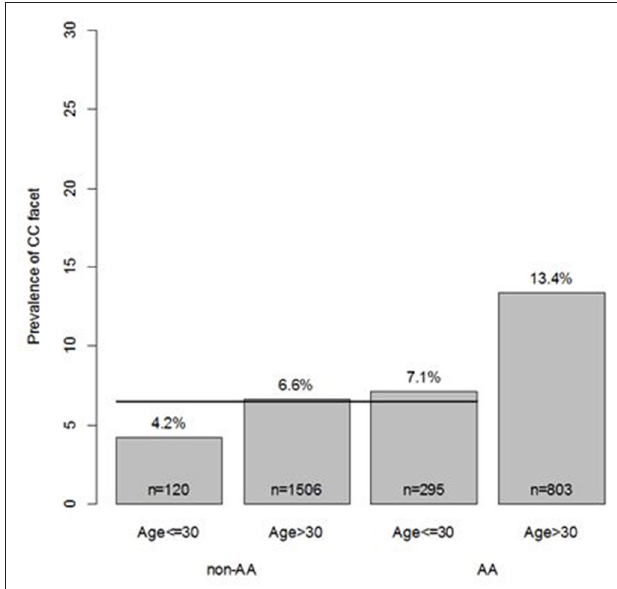
FIGURE 2 | Multivariable modeling of CC facet. In multivariable modeling, considering all models with 2-way interactions, the model that identified the AA and age > 30 group as different from the other groups was found to be the best predictor of CC facet. No other effects (other variables or other interactions) were found to improve upon this